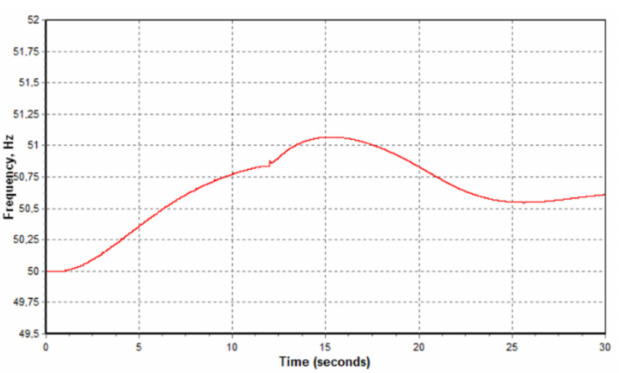
Figure 27. Frequency change in the isolated power system caused by disconnection of the HVDC BtB